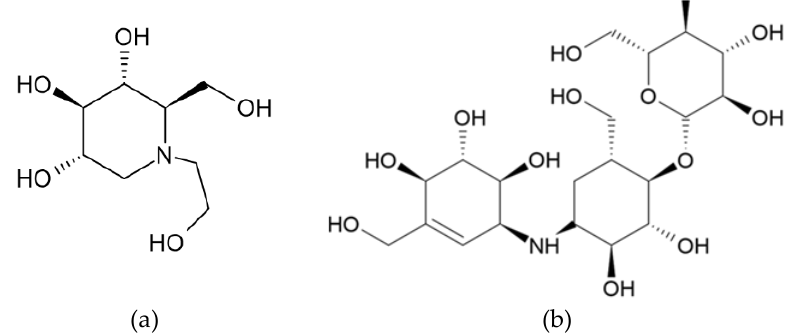
Figure 1. Chemical structure of ( a ) miglitol and ( b ) validamycin